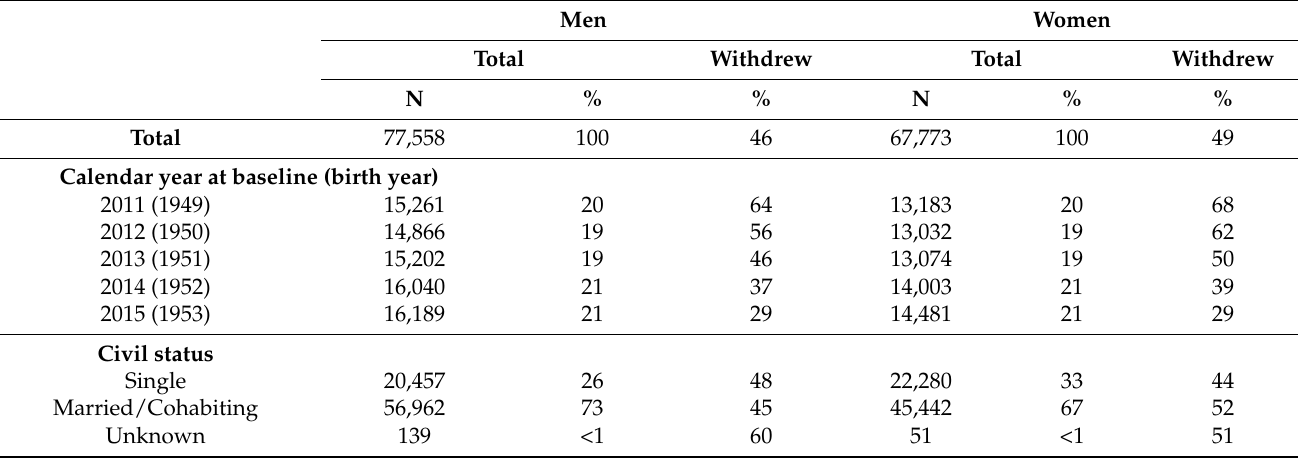
Table 1. Descriptive statistics of persons born between 1949–1953 who were in paid employment in Norway at age 62 (N = 145,331) and the proportion who withdrew from paid employment during the follow-up period